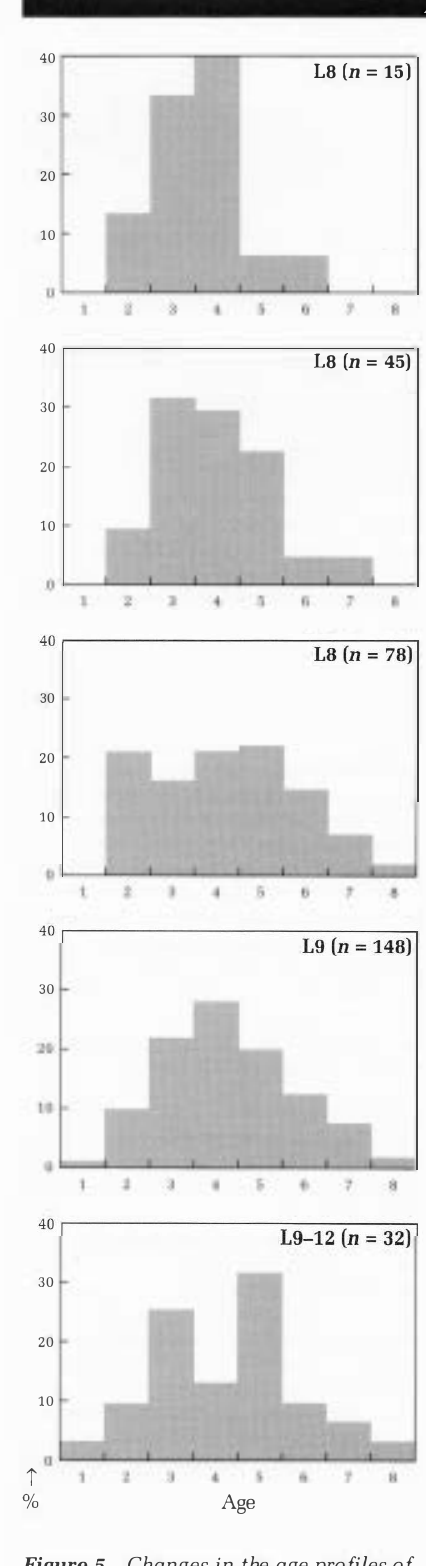
Figure 5 Changes in the age profiles of the top shell {Monodonta lineata) through the mid den depositsatCulverwell (sample column 1]from thetopoflayerB (LB)down to layers 9-12; n =the number of shells analyzed in each